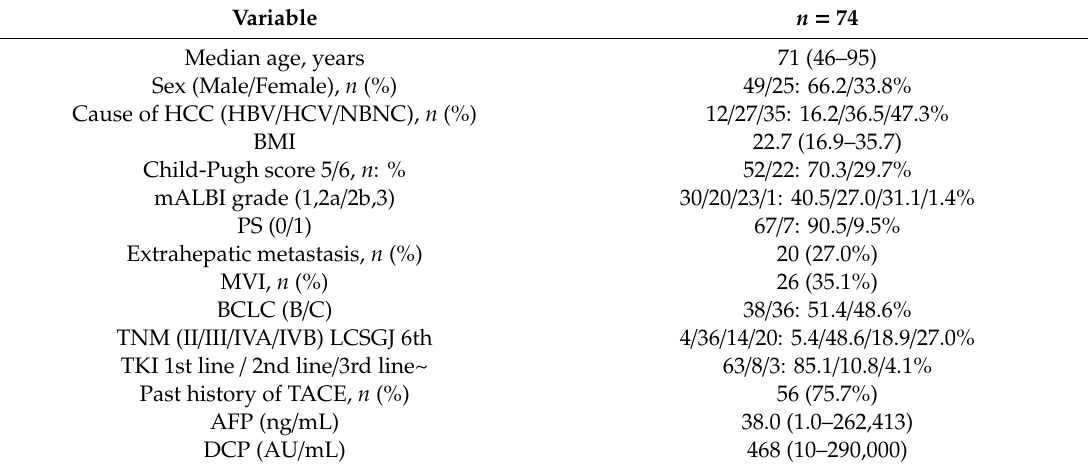
Table 1. Patients